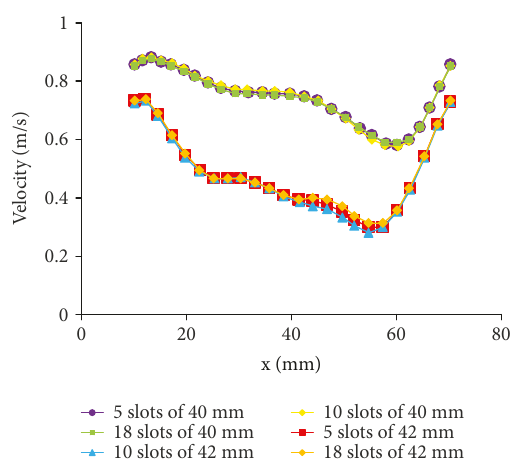
Figure 11: Contrast chart of fl ow velocity under di ff erent number of